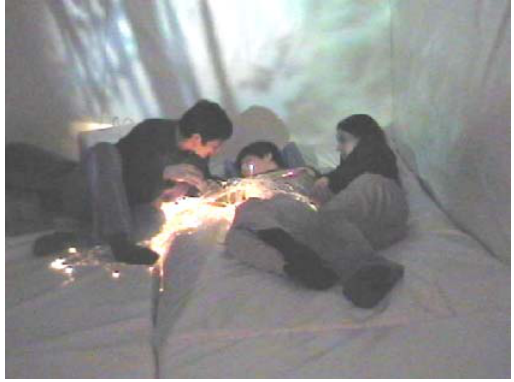
PICTURE 5 . Familial togetherness in the